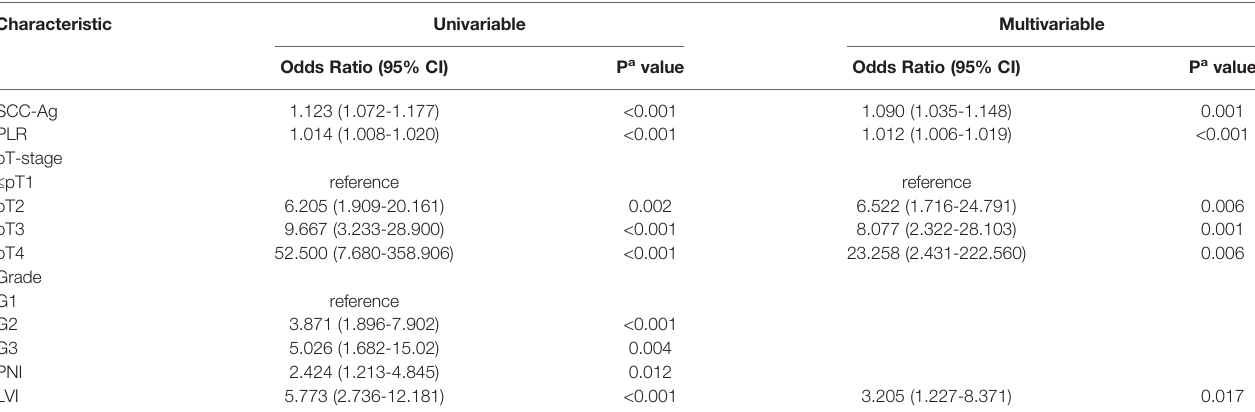
TABLE 3 | Univariable and multivariable